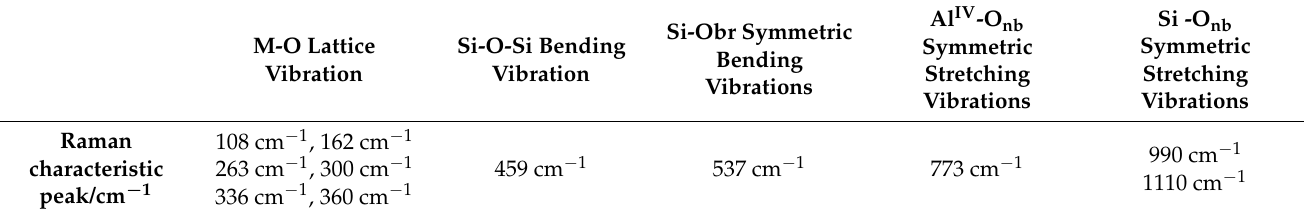
Table 2. Assignment of Raman spectra of scapolite.